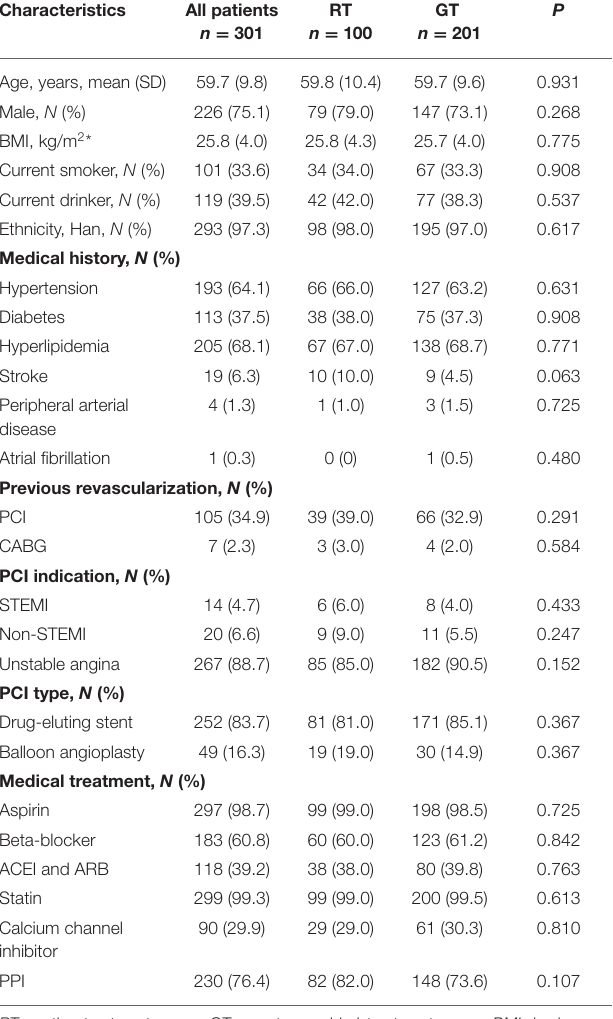
TABLE 1 | Demographic and characteristics of the study population. Characteristics